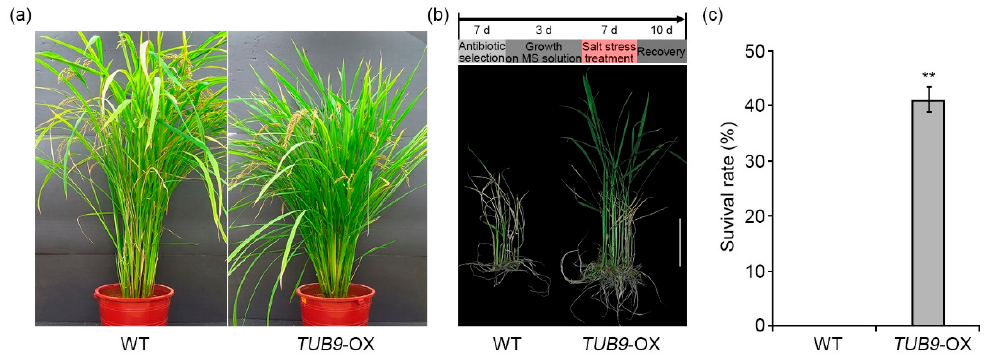
Figure 7 . Characterization of TUB9 -overexpressing transgenic rice plants. ( a ) Comparison of plant growth in wild-type (WT, “Ilmi” cultivar) and TUB9 -overexpressing transgenic rice plants ( TUB9 -OX). Photographs were taken at maturity (milky ripening) stages. ( b ) Comparison of plant tolerance in WT and TUB9 -OX plants to salt stress. Ten-day-old seedlings were treated with 120 mM NaCl for 7 days. After NaCl treatment, plants were recovered in MS medium without NaCl. Scale bars indicate 5 cm. ( c ) Quantitative analysis of survival rate of WT and TUB9 -OX plants after salt stress treatment. Error bars represent the standard deviation (SD) of three independent replicates of the same experiment. Asterisks represent significant differences in the WT (** p ≤ 0.01, Student’s t-test).